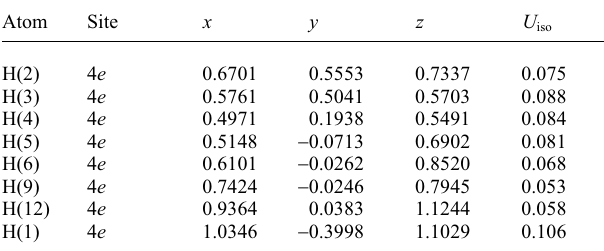
Table 2. Atomic coordinates and displacement parameters (in Å 2 )